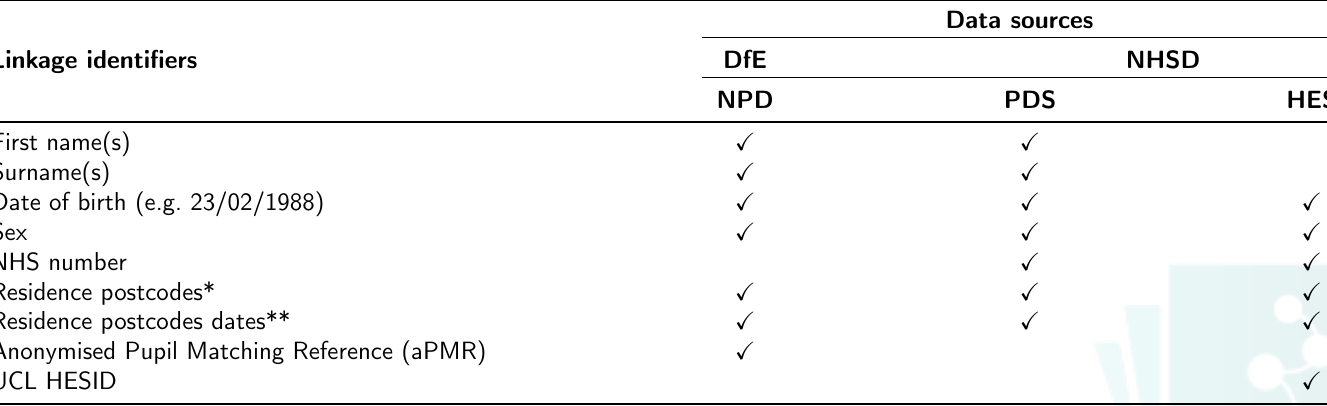
Table 1: Availability of personal identifiers in the national pupil database, personal demographic service and hospital episode